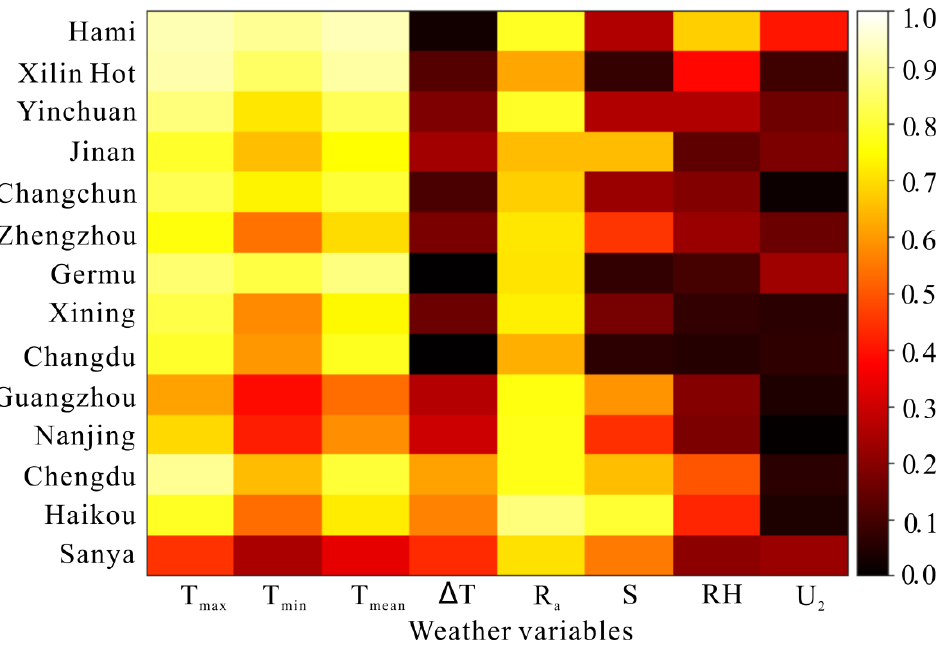
Figure 3. Coefficients of determination (r 2 ) between ET 0 estimates (from FAO PM method) and models’ meteorological parameters from the 14 national meteorological stations. T max , T min and T mean represent maximum, minimum and mean temperature (°C); ∆ T is diurnal temperature range (°C), R a stands for total solar radiation (MJ m − 2 d − 1 ), S, RH and U 2 mean actual sunshine duration (h), relative humidity (%) and wind speed at wind speed at 2 m height (m s − 1 ).